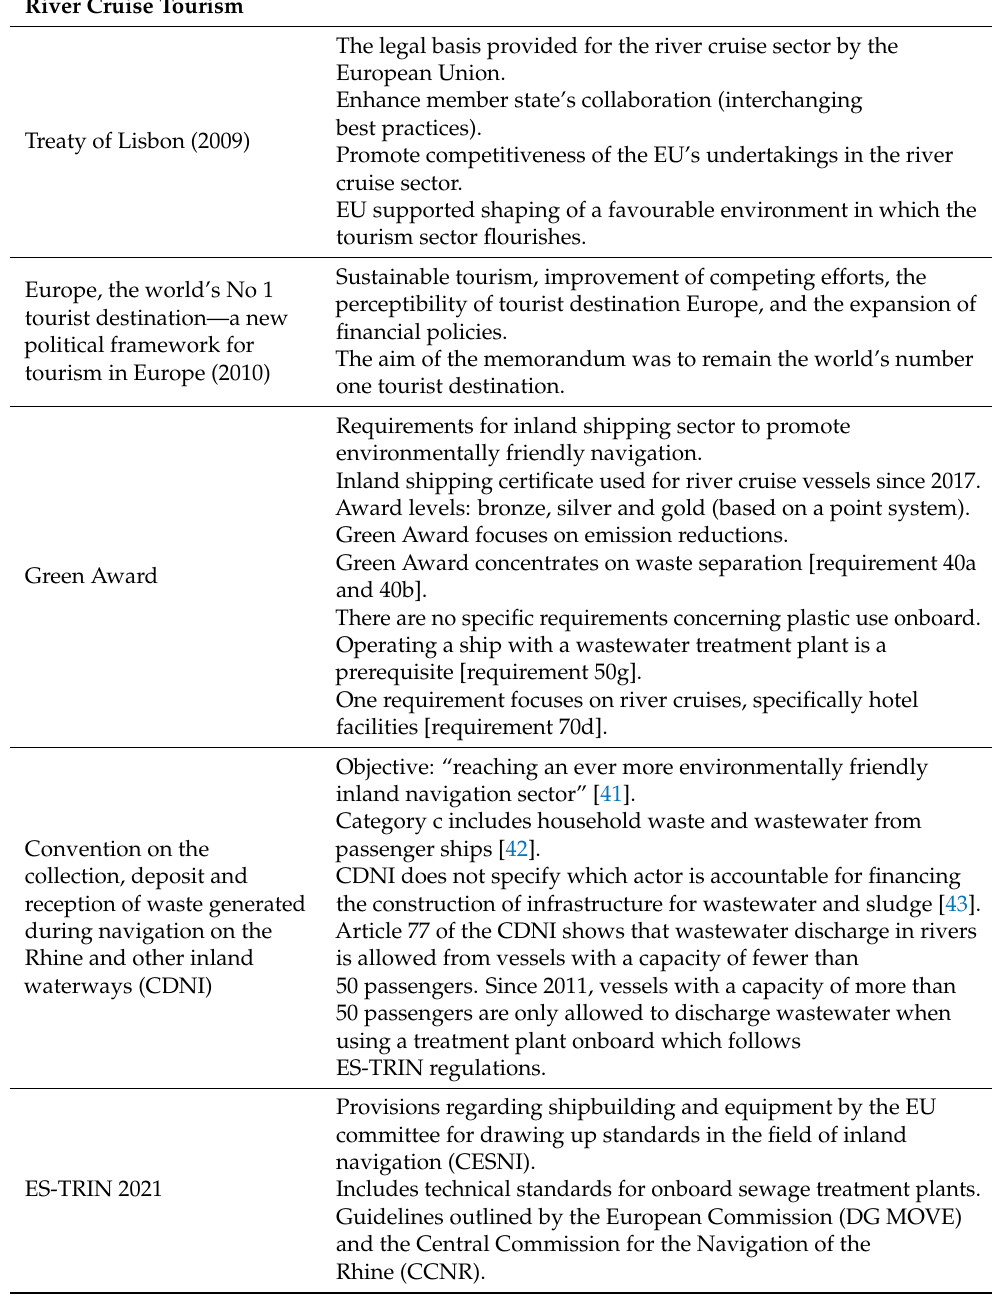
Table 4. Rules of the game dimension for river cruise